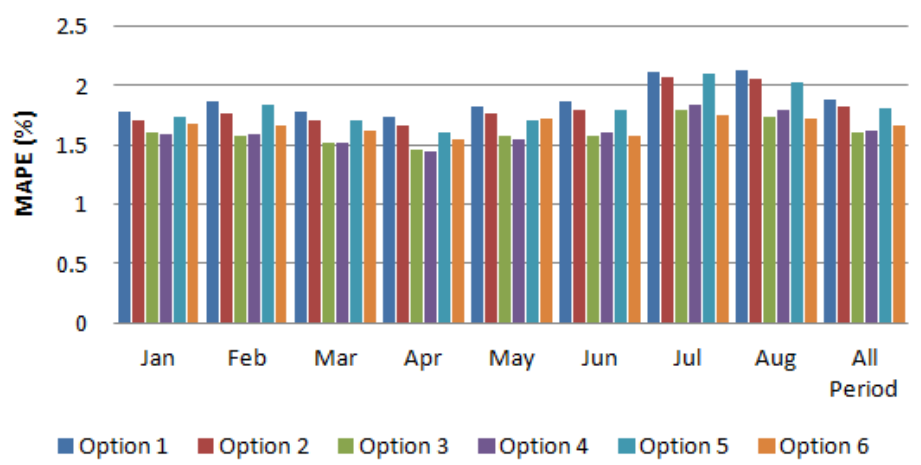
Figure 7. Mean absolute percentage error (MAPE) (%) metric results for examined options (period January–August 2018).